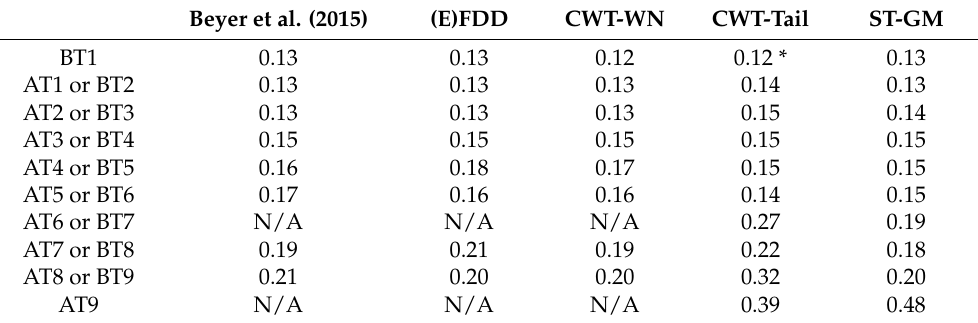
Table 3. Comparison of the results of SHM algorithms with published data in terms of the first natural vibration period. BT: Before Test, AT: After Test. * For CWT-Tail: BT1 period is assigned as 0.12 s which is determined by